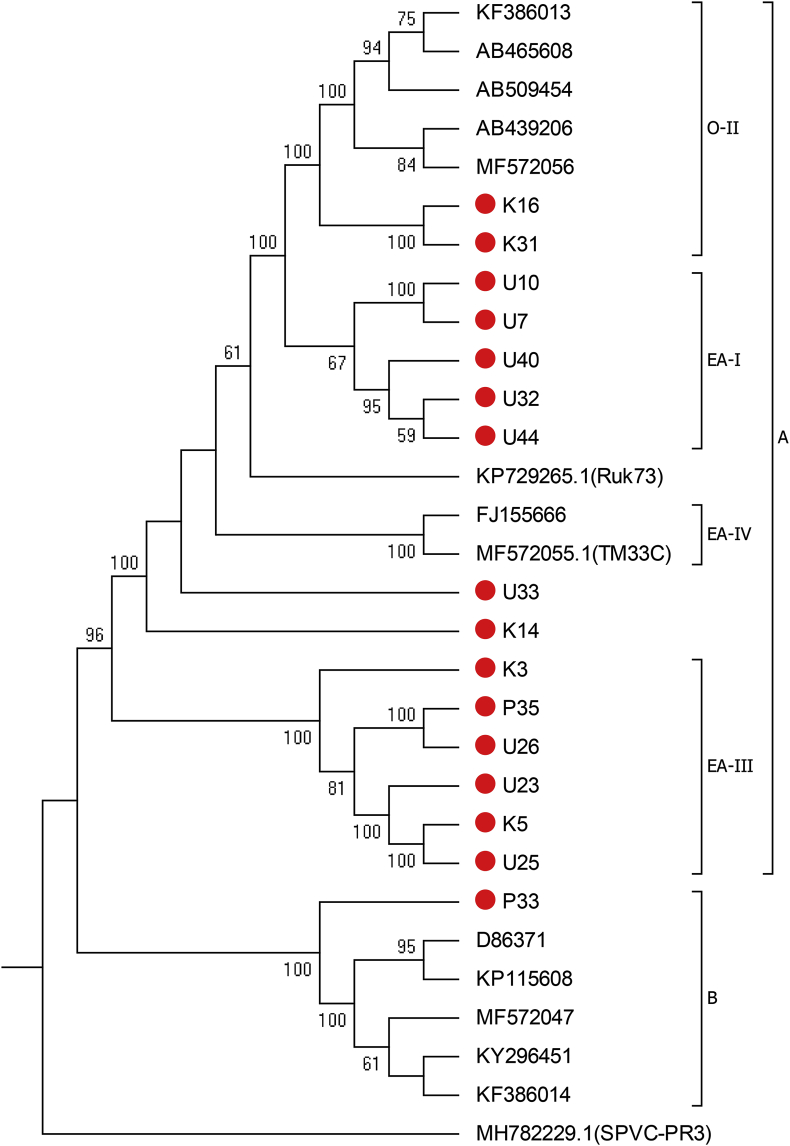
Phylogenetic tree of polyprotein encoding nucleotide sequence. Reference isolate MH782229.1 of sweet potato virus C was used as out group. Red colour indicate isolates from this study. (For interpretation of the references to colour in this figure legend, the reader is referred to the Web version of this article.)